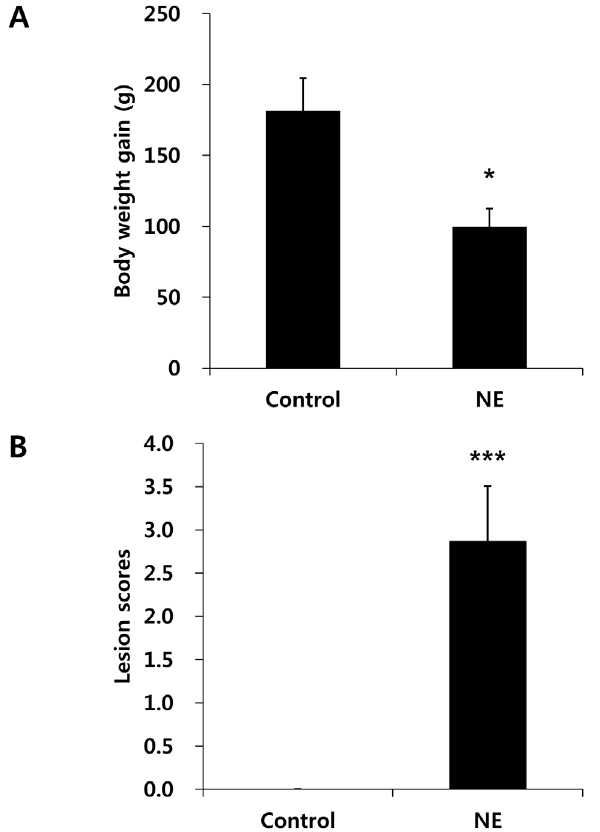
Fig. 1. Effect of C. perfringens / E. maxima co-infection of Ross chickens on body weight gains and intestinal lesion scores. (A) Chickens were uninfected (Control) or co-infected with C. perfringens and E. maxima (NE) and body weight gains were measured between days 0–9 post-infection with E. maxima . (B) Gut lesion scores were determined at day 2 post-infection with C. perfringens on a scale from 0 (none) to 4 (high) in a blinded fashion by three independent observers. Each bar represents the mean ¡ SD value (n 5 8). *, P , 0.05; ***, P , 0.001.